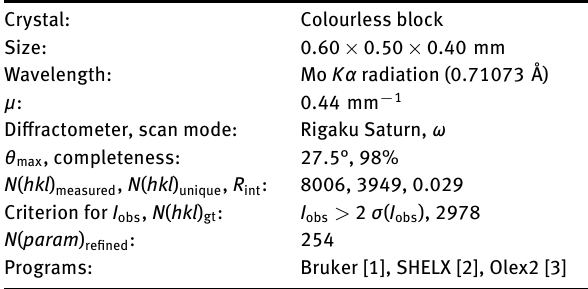
Table 1 contains crystallographic data and Table 2 contains the list of the atoms including atomic coordinates and dis- placement parameters.